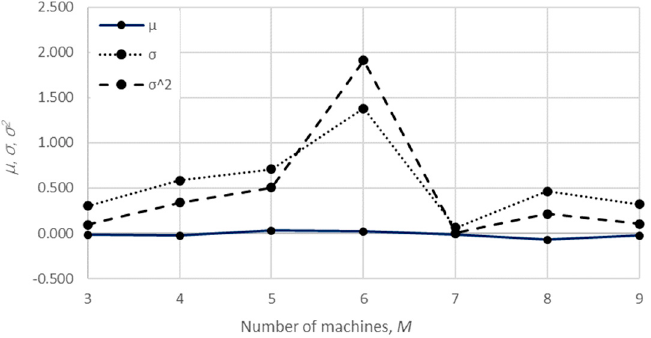
Figure 9. The relative error of the WIP concerning the number of machines—AGG procedure.